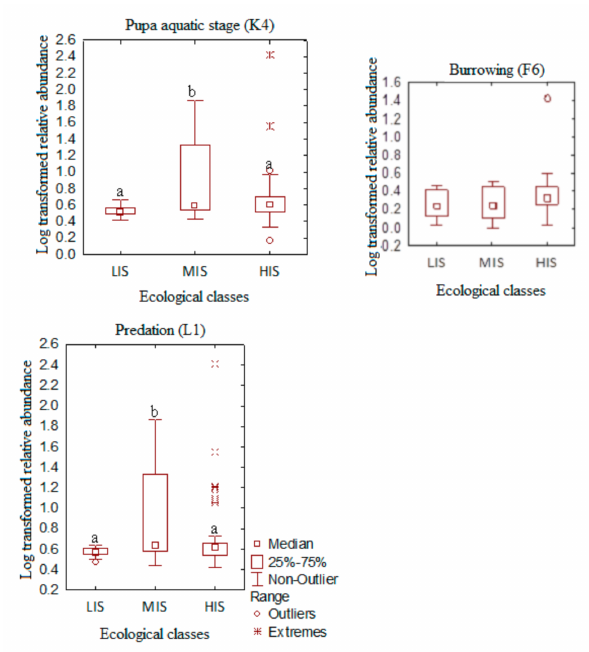
Figure 4. Pattern of distribution of tolerant traits across the three ecological classes in the present